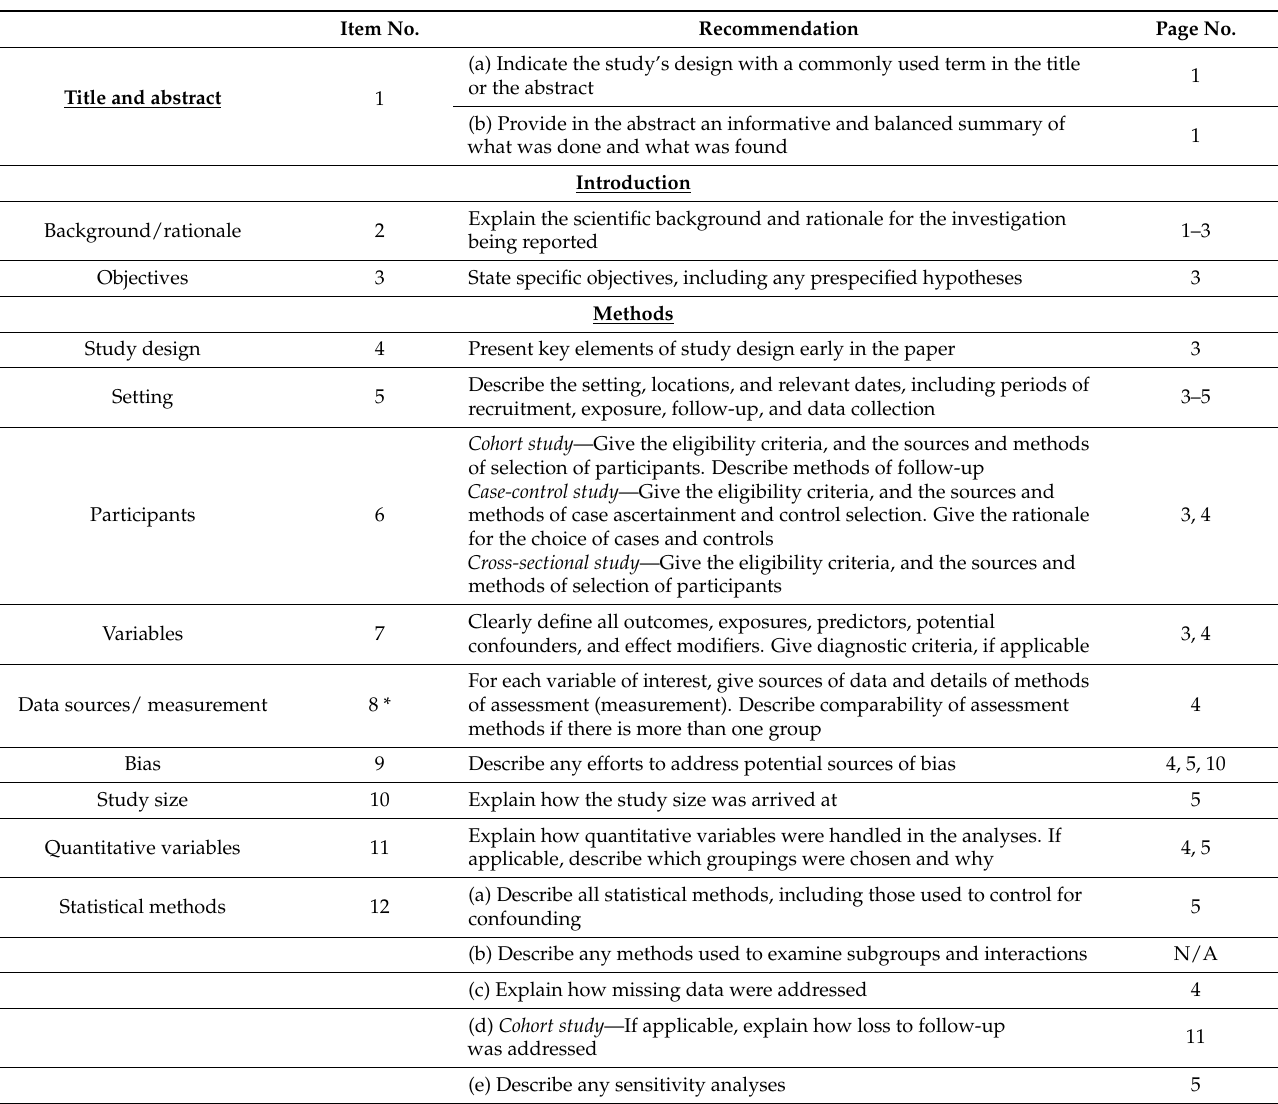
Table A2. STRengthening the Reporting of OBservational studies in Epidemiology (STROBE): check- list for reporting of observational studies. This table has been included in line with publishing guide- lines for observational studies. Table reproduced from https://www.strobe-statement.org/checklists/ (accessed 10 January